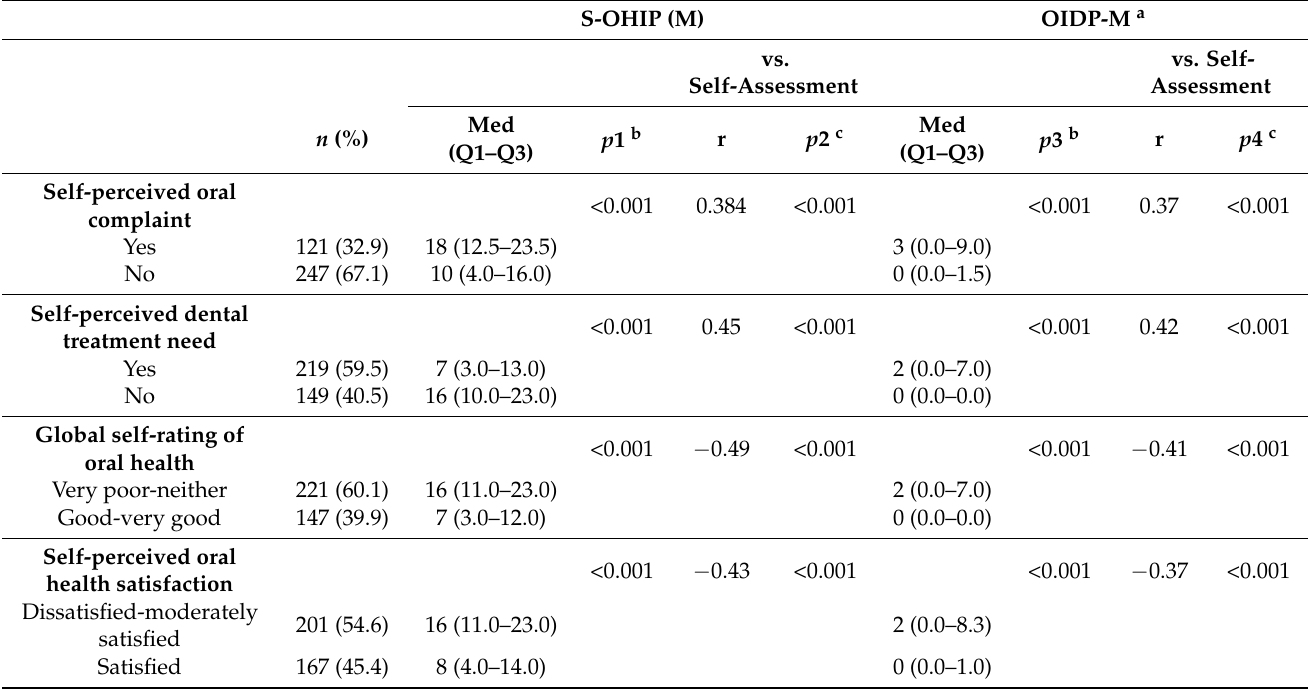
Table 2. Comparison and associations between S-OHIP(M) or OIDP-M scores and self-perceived oral health assessments ( n = 368). S-OHIP (M) OIDP-M a vs. Self-Assessment